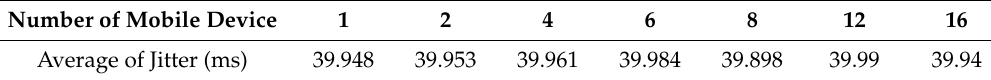
Figure 18. Measuring the jitter by increasing the number of mobile devices. Table 2. Average Jitter by increasing the number of mobile devices.